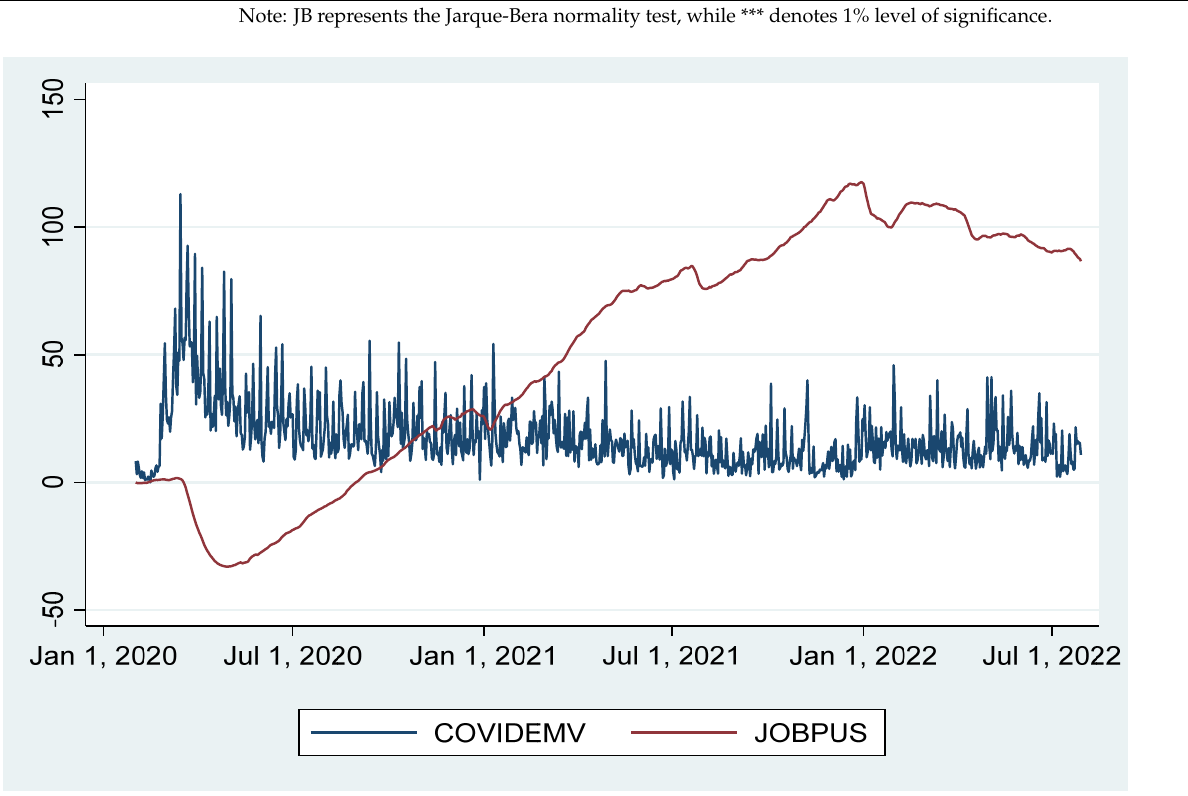
Figure 1. Trend of US manufacturing job postings and COVIDEMV.